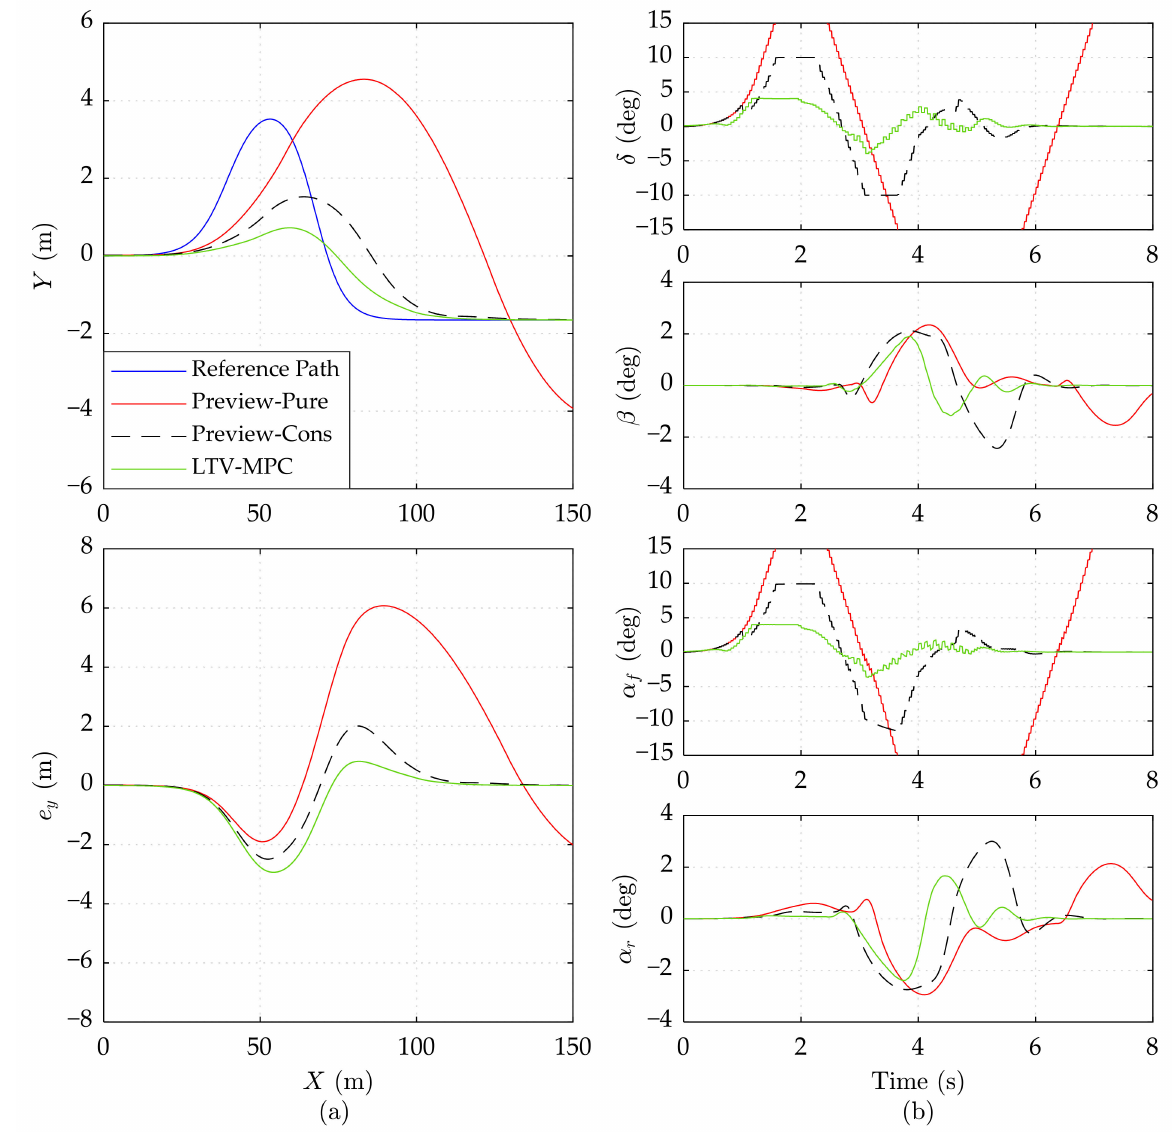
Figure 8. Simulation results of three controllers on the low adhesion road at 20 m/s speed. ( a ) Vehicle driving trajectory, lateral error e y . ( b ) Front wheel steering angle δ , mass center slip angle β , front wheel slip angle α f , and rear wheel slip angle α r . The results of Preview-Pure beyond range are cut